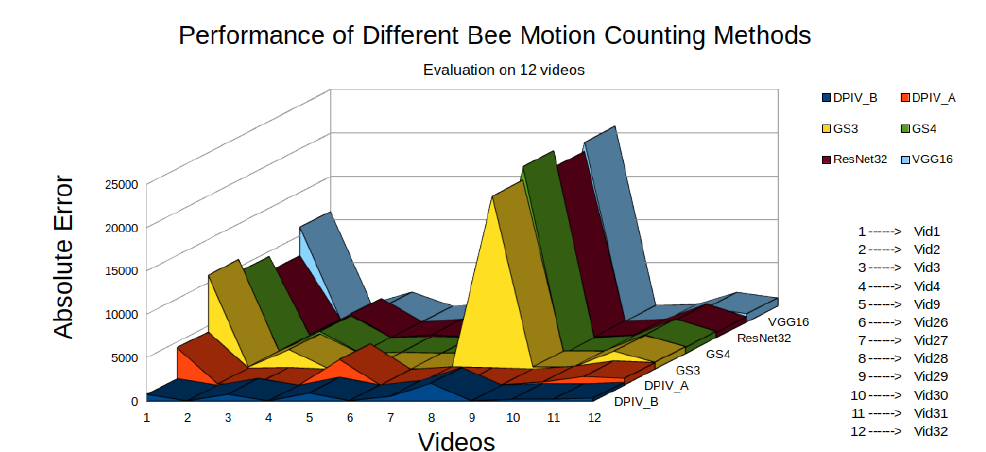
Figure 17. Absolute omnidirectional error of six bee counting algorithms on twelve evalua- tion videos; VGG16 refers to MOG2/VG16; ResNet32 refers to MOG2/ResNet32; GS3 refers to MOG2/ConvNetGS3; GS4 refers to